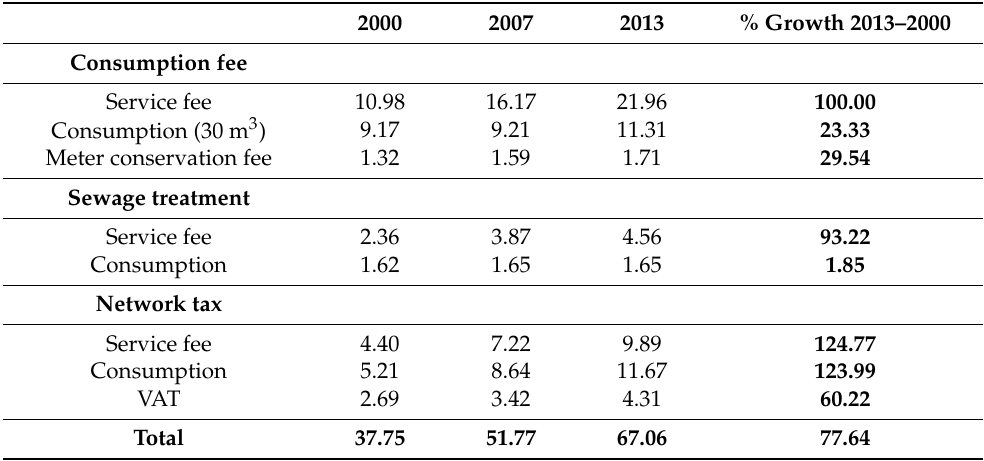
Table 5. Evolution of the water price bill (30 m 3 /3 months), 2000–2013 ( € ). Source: AMAEM. Elaborated by the authors.